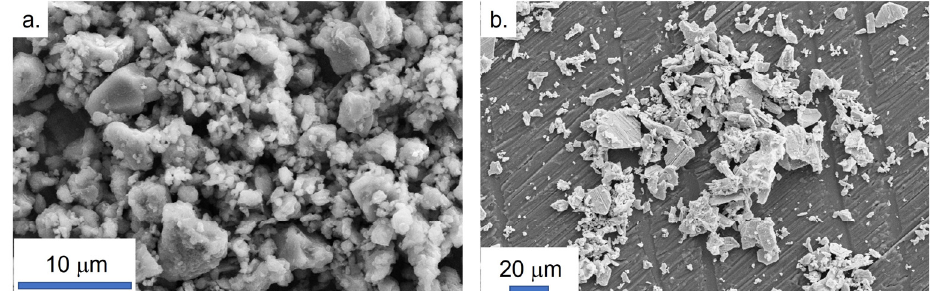
Figure 3. SEM observations of the raw powders. ( a ) Aluminum nitride; ( b ) cerium oxide.